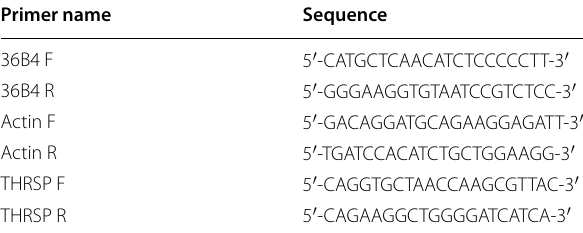
Table 1 Sequences of primers used for qPCR analysis Primer